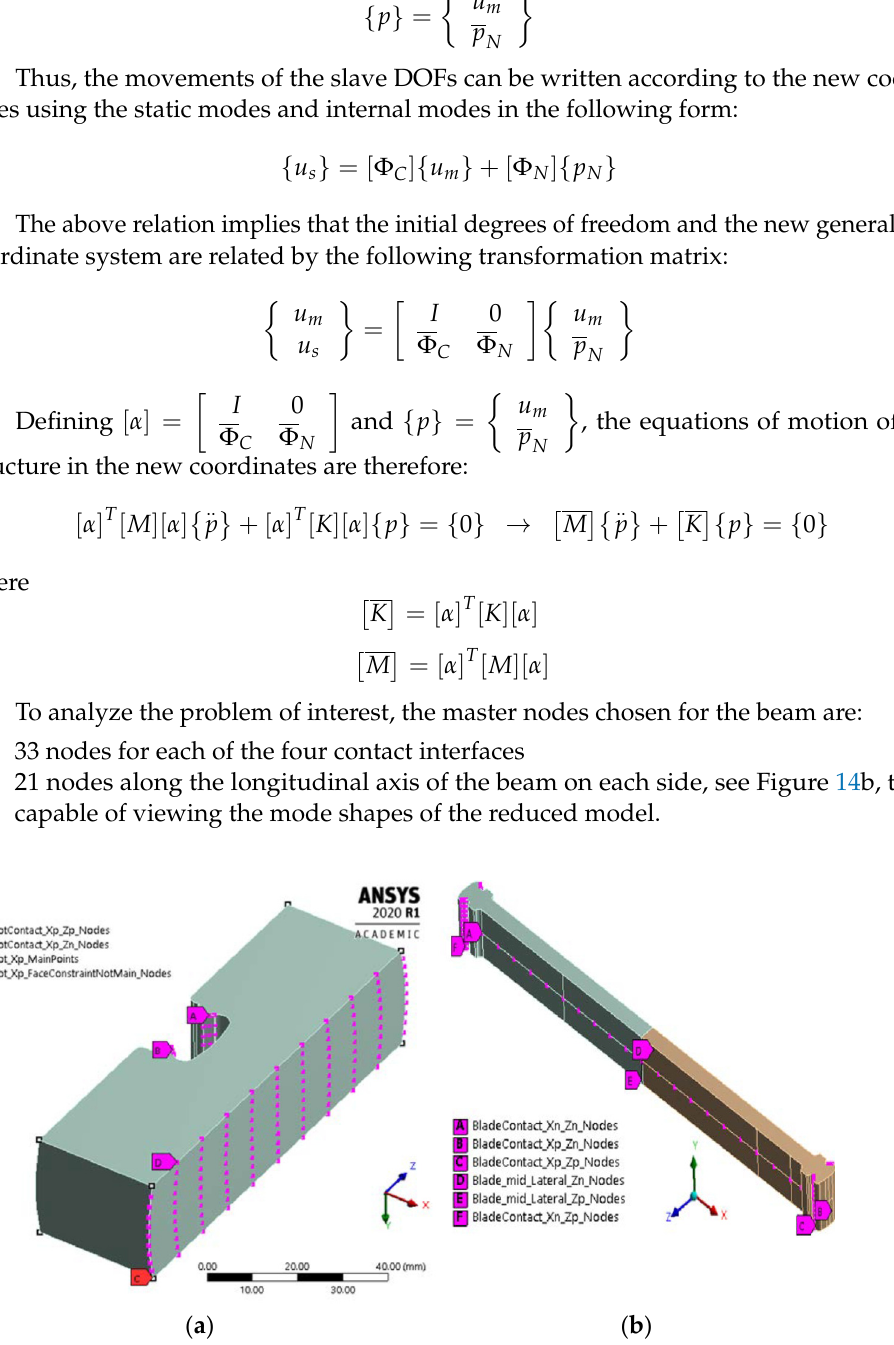
( b ) Figure 15. Assembly of super-element: ( a ) mass matrices and ( b ) stiffness matrices. By dividing the degrees of freedom into two categories, namely free (F) and the con- strained (C), it was possible to split the mass and stiffness matrices as: (cid:4666)−𝜔 (cid:2870) [𝑀 (cid:3008)(cid:3013)(cid:3016)(cid:3003) ] + [𝐾 (cid:3008)(cid:3013)(cid:3016)(cid:3003) ](cid:4667){𝒒} = {𝟎} + {𝑹 (cid:3049) } → { (cid:4666)−𝜔 (cid:2870) [𝑀 (cid:3007)(cid:3007) ] + [𝐾 (cid:3007)(cid:3007) ](cid:4667){𝒒 (cid:3007) } = {𝟎} (cid:4666)−𝜔 (cid:2870) [𝑀 (cid:3004)(cid:3007) ] + [𝐾 (cid:3004)(cid:3007) ](cid:4667){𝒒 (cid:3007) } = {𝑹 (cid:3049) } (12) The modal analysis was then carried out using the matrices [𝑀 (cid:3007)(cid:3007) ] and [𝐾 (cid:3007)(cid:3007) ] , ob- tained from the global matrices [𝑀 (cid:3008)(cid:3013)(cid:3016)(cid:3003) ] and [𝐾 (cid:3008)(cid:3013)(cid:3016)(cid:3003) ] by eliminating the rows and col- umns corresponding to the degrees of freedom of the bases of the two slots. The structure of the resulting matrices is exhibited in Figure 16.